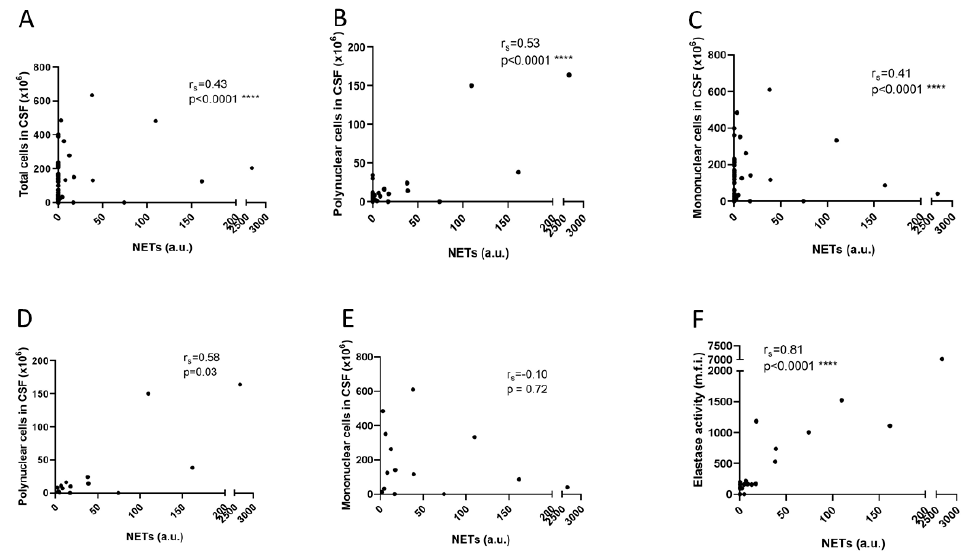
Figure 1. Correlations between cell counts in the CSF and NET remnants: ( A – C ) ( N = 111 children) and ( D – E ) ( N = 14 children). Correlation between NET remnants and elastase activity: ( F ) ( N = 28; 13 NET-positive and 15 NET-negative cases).